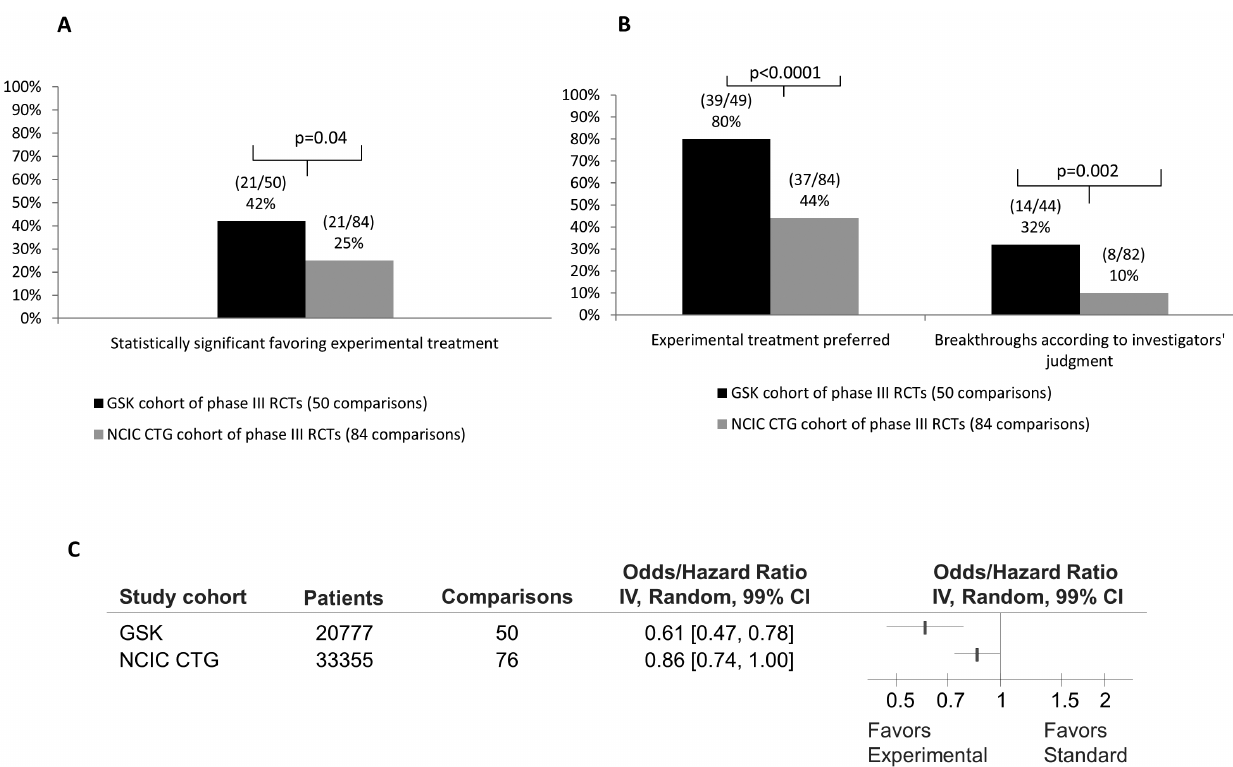
Figure 2. Success rate of GlaxoSmithKline (GSK) compared with National Cancer Institute Canada Clinical Trials Group (CTG) cohort of studies. (A) Distribution of success rate according to statistical significance of the results for the primary outcome; (B) Distribution of success rate according to investigators’ judgments. *Data for one comparison in the GSK cohort were not available to make a decision on investigators’ judgments. For ten comparison in the GSK cohort and two comparisons in the CTG cohort data were not available to make a judgment on whether investigators considered the experimental treatment to be a breakthrough (=fit for adoption as standard of care’’). **The results were available in the summary format (unpublished). Therefore, investigator judgments were not possible to assess for 10 comparisons. (C) Forest plot showing quantitative pooling of data on primary outcome for studies conducted by CTG and GSK. The summary pooled estimate (odds/hazard ratio) is indicated by rectangles, with the lines representing 99% confidence intervals (CIs).